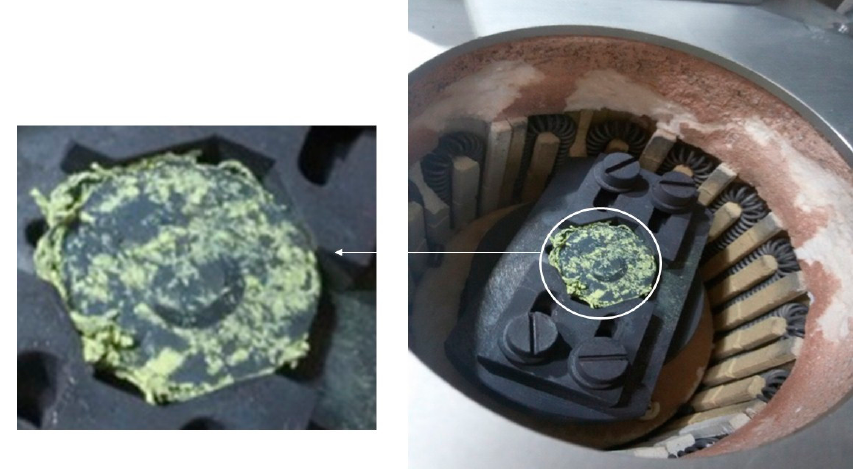
Figure 7. Digital image of the nano-sized WC-9% Co sample inside the heating chamber after the wear test was conducted at a normal load of 30 N, a speed of 0.1 m/s and temperature of 600 °C.